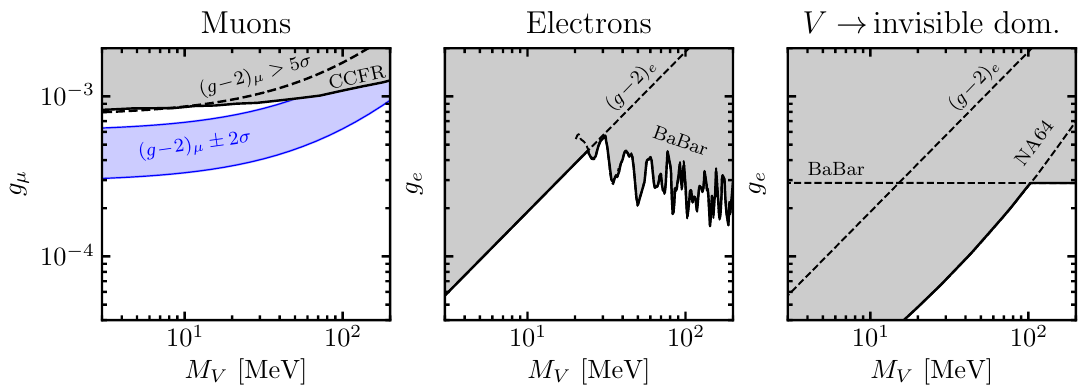
Figure 7 . Bounds on the vector couplings of a light vector, V , to muons (left) and electrons (center and right) as a function of the vector mass. The central plot assumes the absence of a relevant invisible decay rate of the vector. The right plot assumes that the invisible decays dominate. The constraints from the ( g (cid:0) 2) of the muon and the electron are indirect constraints from having V in the loop, while the constraints from BaBar [31] and NA64 [55, 56] come from direct decays to electrons. On the left panel, the constraint from (cid:23) -trident production based on measurements by the CCFR collaboration [52] assumes that the V couples with equal strength to the left-handed muon and muon neutrino [51], i.e., to the SU(2) doublet L (cid:22) . This constraint does not apply to models in which V does not couple to neutrinos, i.e., dark-photon models.